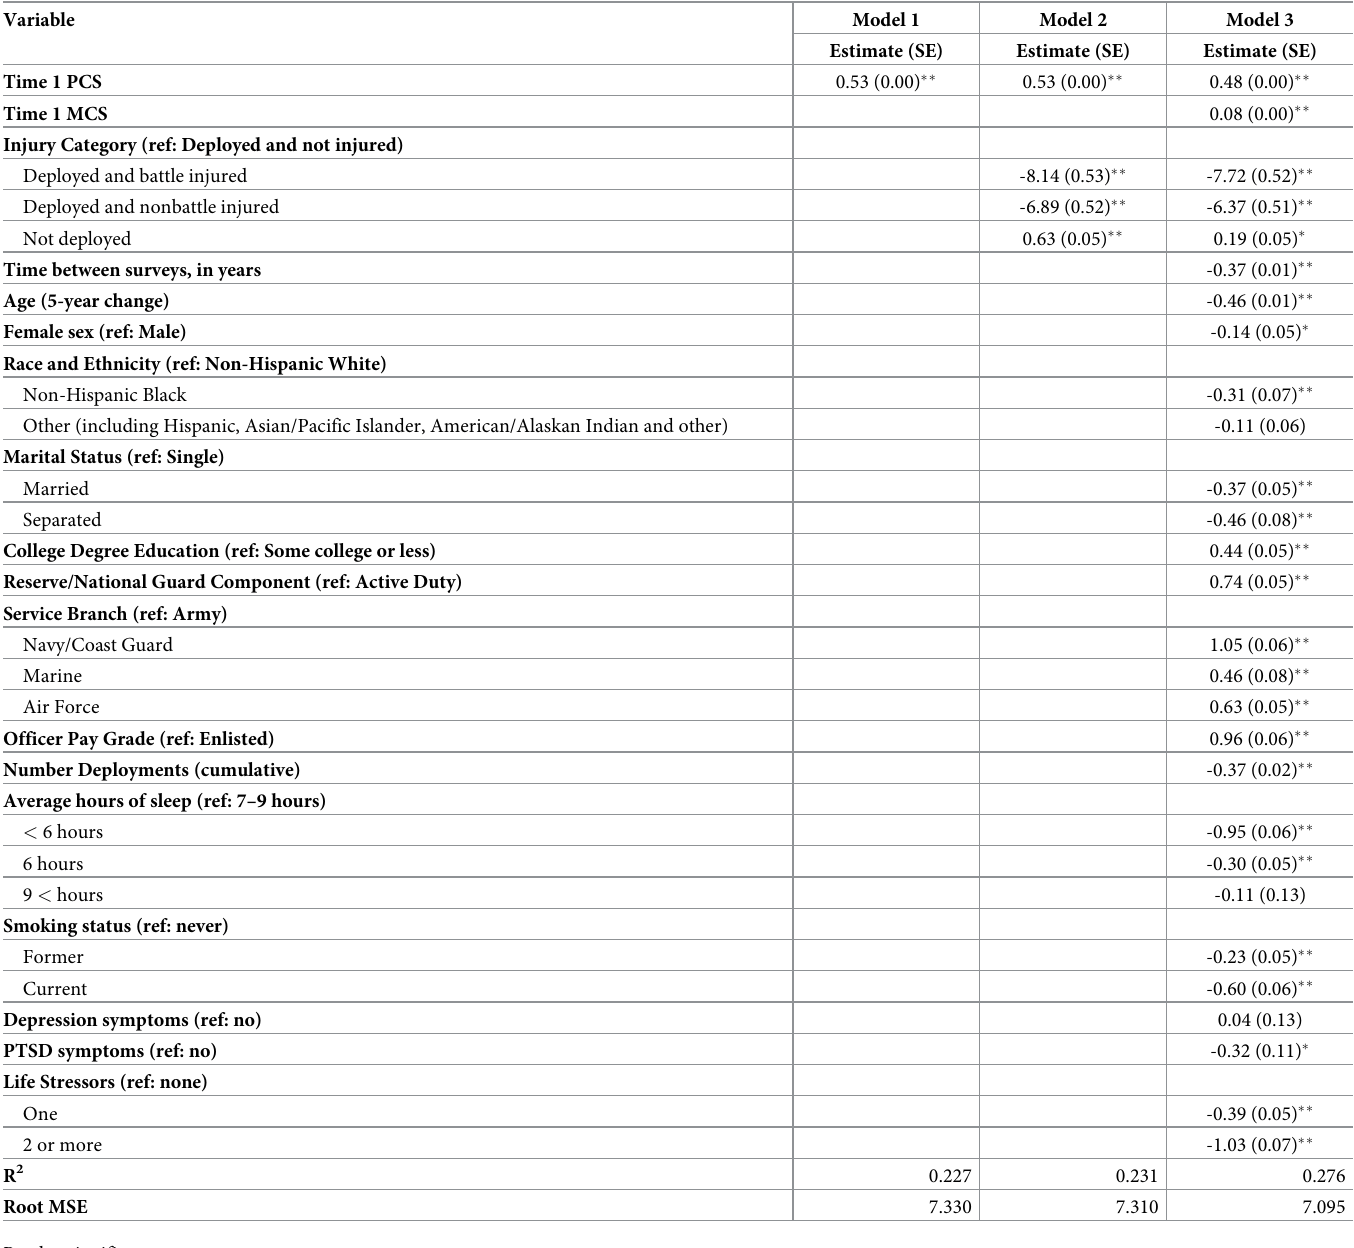
Table 3. Associations between main exposure and covariates with Physical Composite Scores (PCS) among Millennium Cohort participants, n = 118,054.